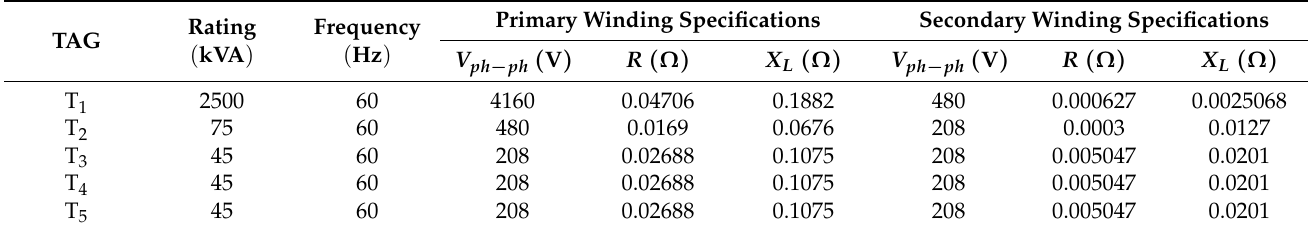
Table A2. Microgrid testbed transformers specifications.